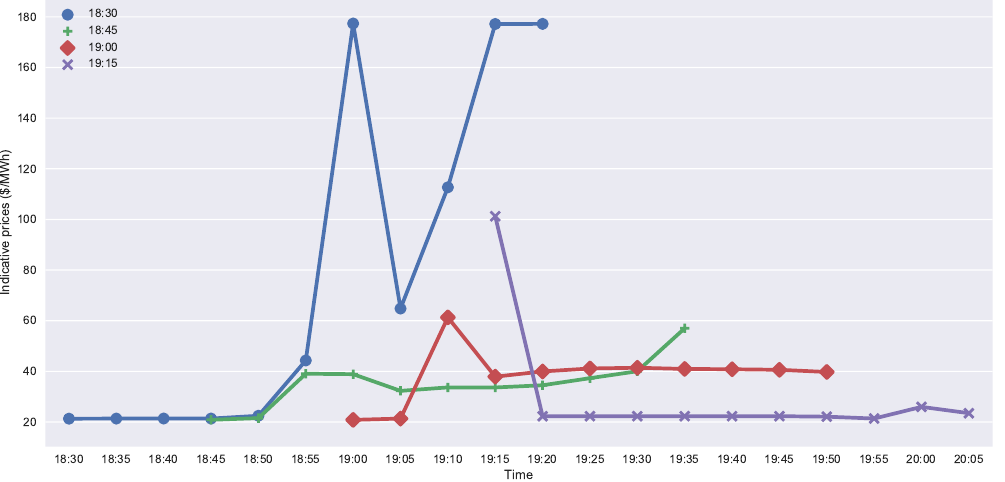
Figure 7. Ercot indicative prices at the South Hub.